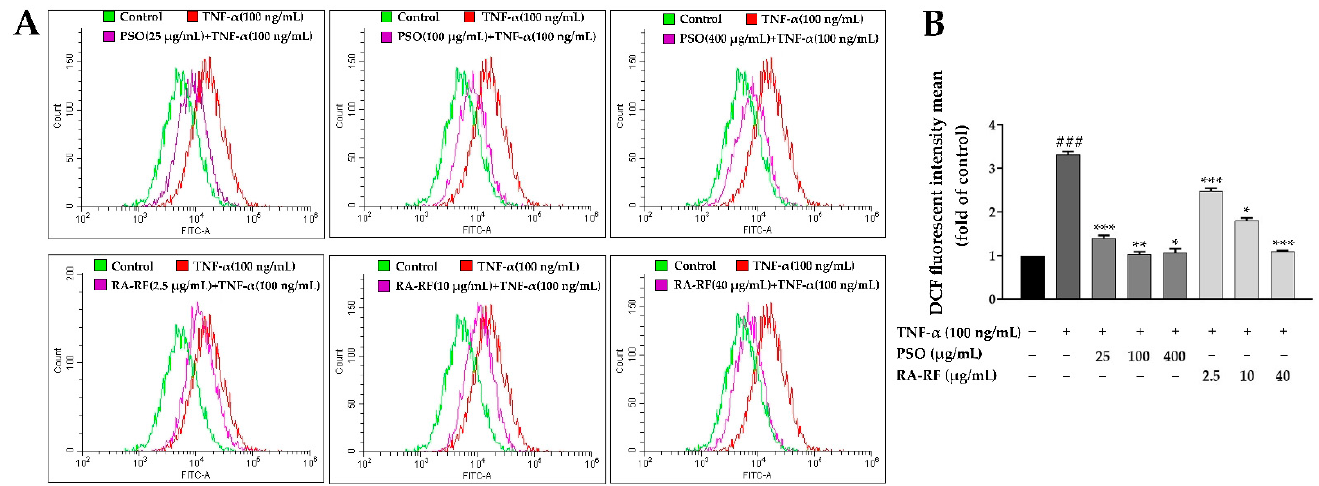
Figure 5. Reactive oxygen species (ROS) generation by flow cytometry. ROS generation level is exhibited as mean ± SD of fluorescence intensity in folds compared to that of the control (without TNF- α ) from three independent experiments by using fluorescence probes: DCFH-DA ( A ). A Bar graph depicted the DCF fluorescence intensity of PSO (25, 100 and 400 µg/mL) or RA-RF (2.5, 10 and 40 µg/mL) treated sets, followed by treatment with or without 100 ng/mL TNF- α in A549 cells ( B ). All assays were performed in triplicate; data are presented as mean ± standard deviation ( ### p <0.001 vs. the control group; * p < 0.05, ** p < 0.01, *** p < 0.001 vs. (+) TNF- α induced group).